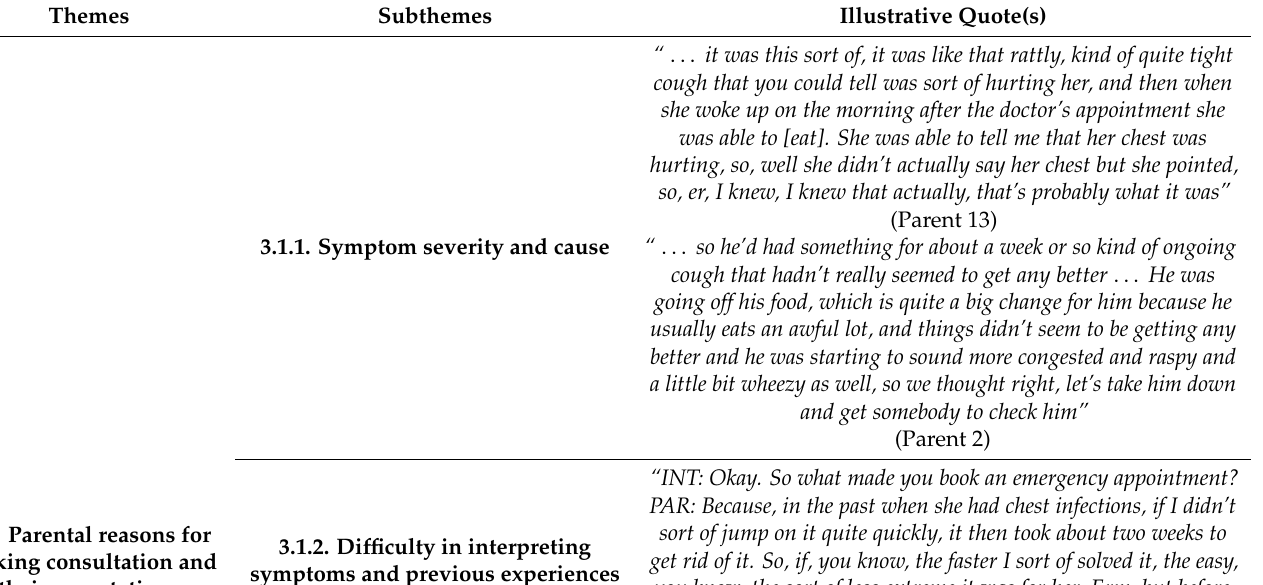
Table 1. Summary of key